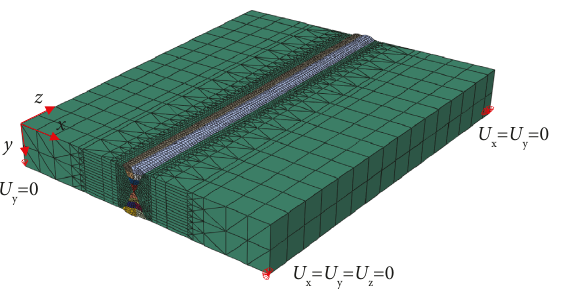
Figure 6: Mesh model.